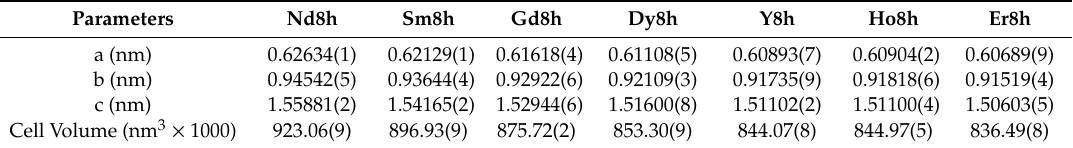
Table 1. Lattice parameters and unit cell volume of rare-earth carbonates with tengerite-type structure.